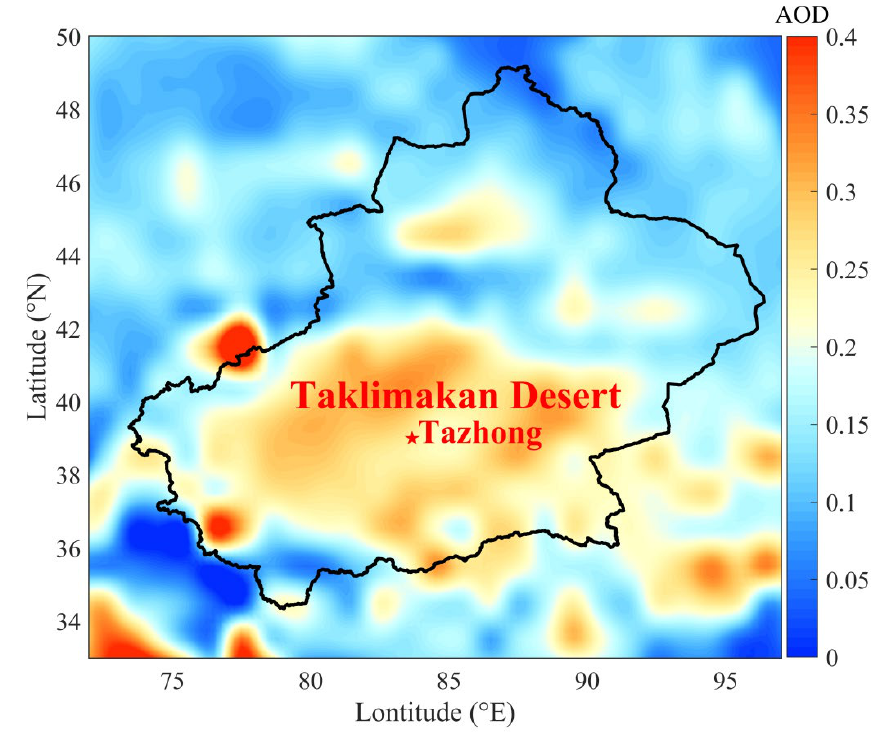
Figure 12. Spatial distribution of average AOD values between March 2008 and February 2010 on non-dust days over the Taklimakan Desert.